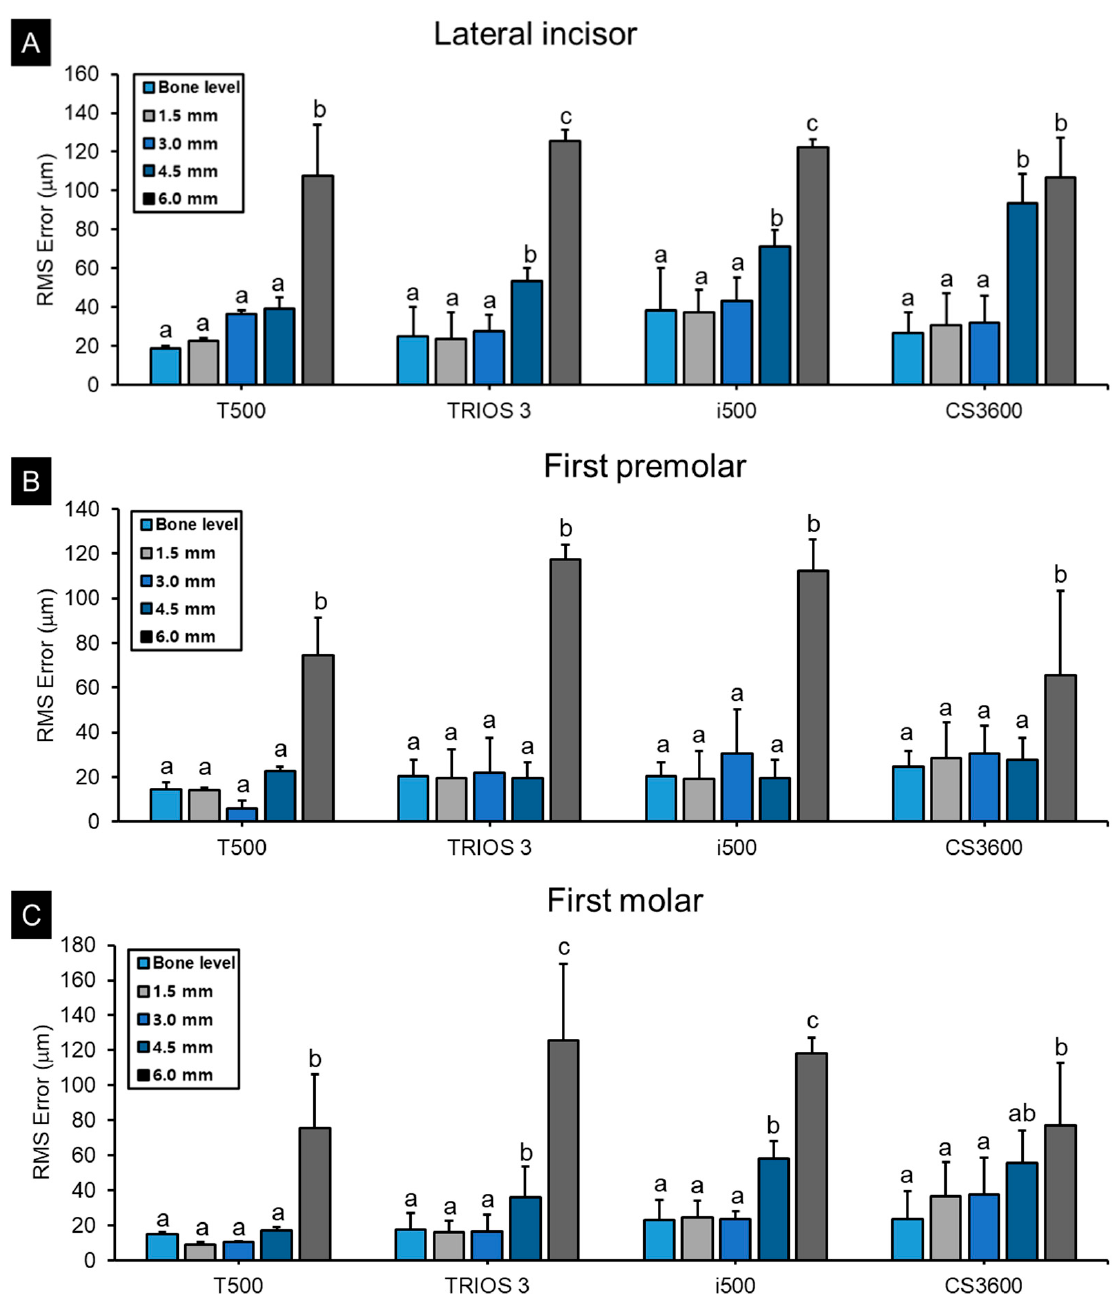
Figure 7. Trueness according to tooth position: ( A ) lateral incisor; ( B ) first premolar and ( C ) first molar. Different lowercase letters indicate significant differences within each scanner group. Data are mean and standard deviation values.